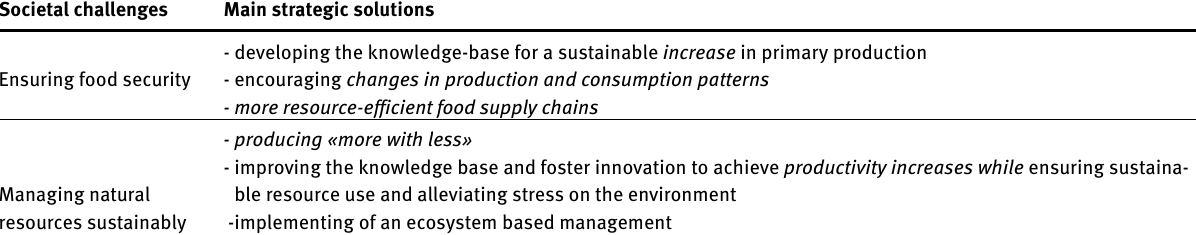
Societal challenges Main strategic